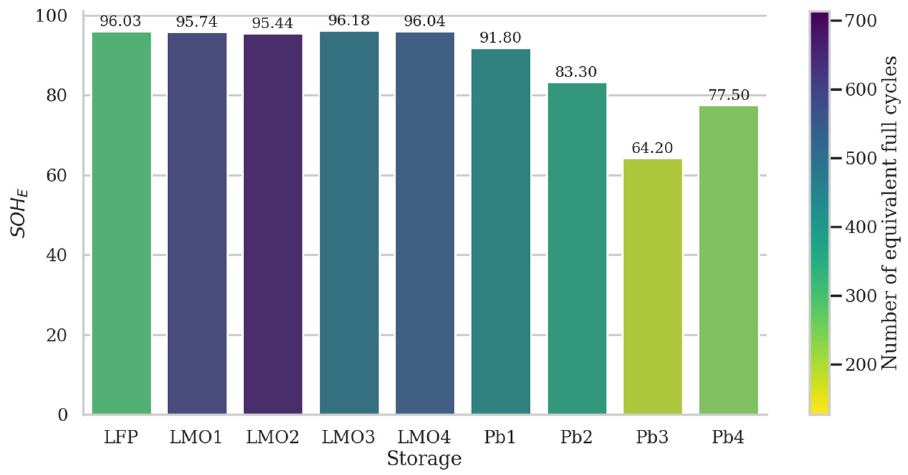
Figure 13. SOH of the battery units after four years according to capacity